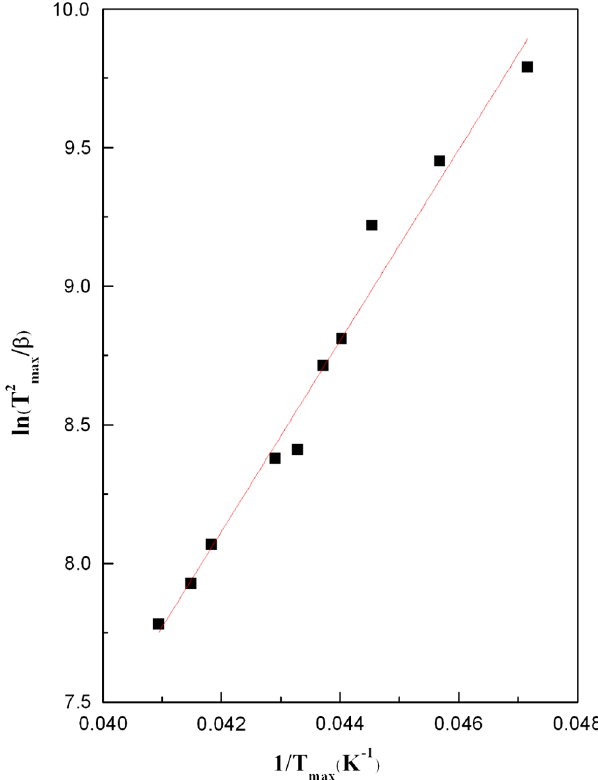
(cid:2) 1 for a series of =(cid:1) Þ versus T FIG. 4. (Color) Plot of ln ð T 2 max max ¼ 19 K , (cid:1) ¼ 2160 L , and vary- TPD spectra taken at fixed T ad is the temperature corresponding to the FIG. 5. Saturated molecular hydrogen content adsorbed on ing heating rate (cid:1) . T max desorption rate maximum. MWCNTs as a function of adsorption temperature of T